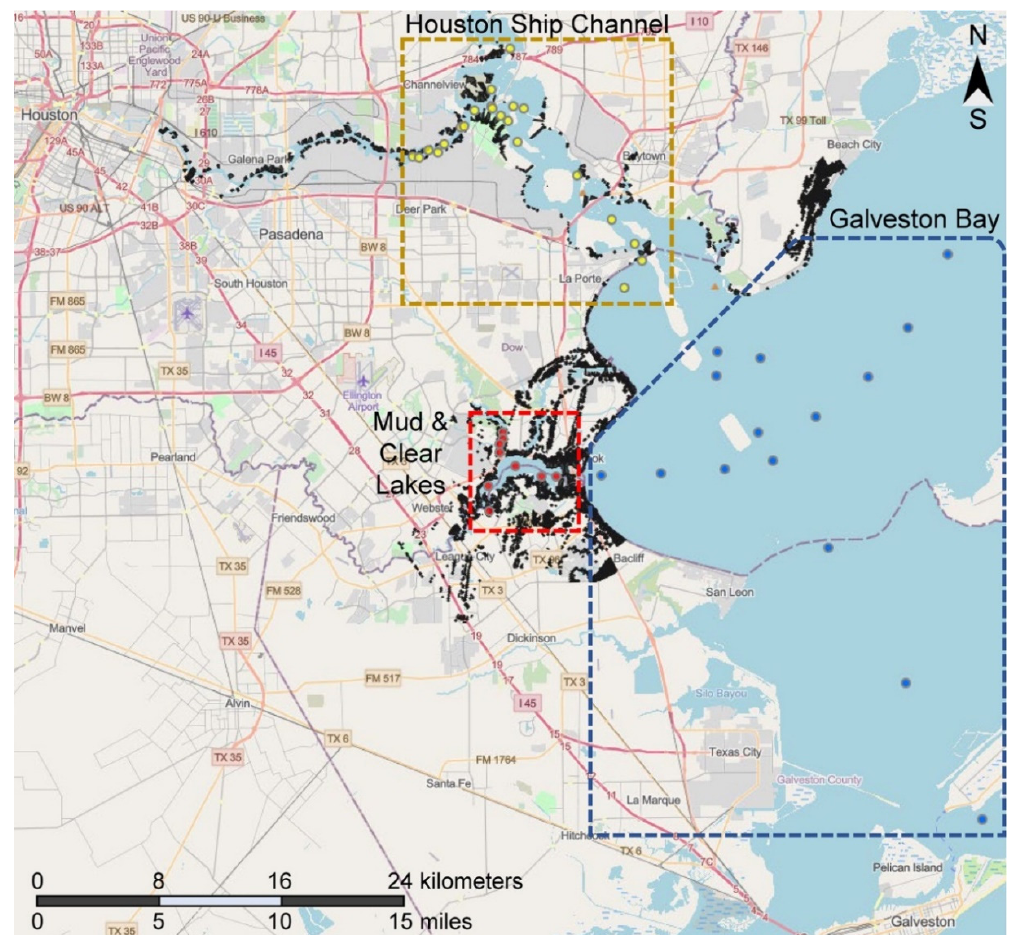
Figure 1. Map of the study area of Houston Ship Channel and Galveston Bay in Houston, Texas. Black dots represent areas of potential sediment deposition on shore after a major hurricane (see Section 2.1 for details). Circles represent individual sediment sampling sites, which are divided into three areas: samples from the Houston Ship Channel (yellow), Mud and Clear Lakes (red), and Galveston Bay (blue). See Supplementary Table S1 for exact coordinates of each sampling site. Background map is from ESRI/OpenStreetMap.